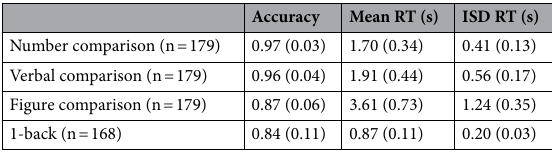
Table 1. Mean performance (SD) in the perceptual speed and 1-back